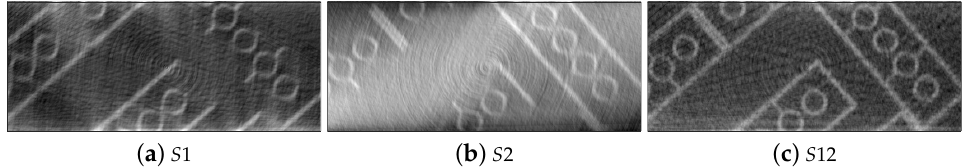
Figure 7. Reconstructions of the test phantom datasets from single ( a , b ) and dual ( c ) X-ray source of the 3D 2 YMOX system with 60 ◦ missing wedge of either single system. The reconstruction of dual-source dataset ( c ) show that the missing wedge artifact can be corrected by incorporating both single datasets into the stereo